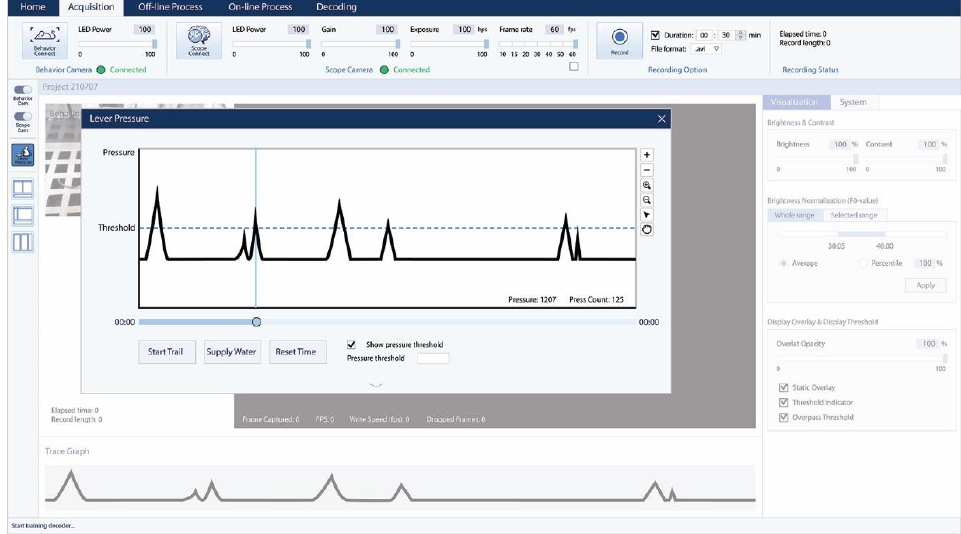
Figure 6. Integration of display- and control-related functions of lever pressure gauge in a new O-BMI system (illustrated).